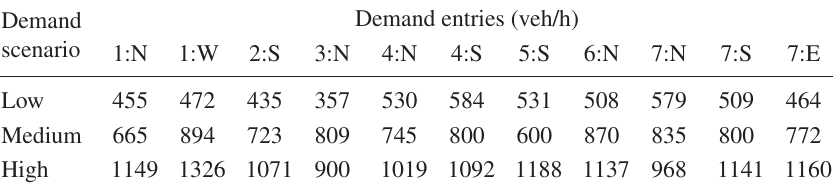
Table 2. Traffic